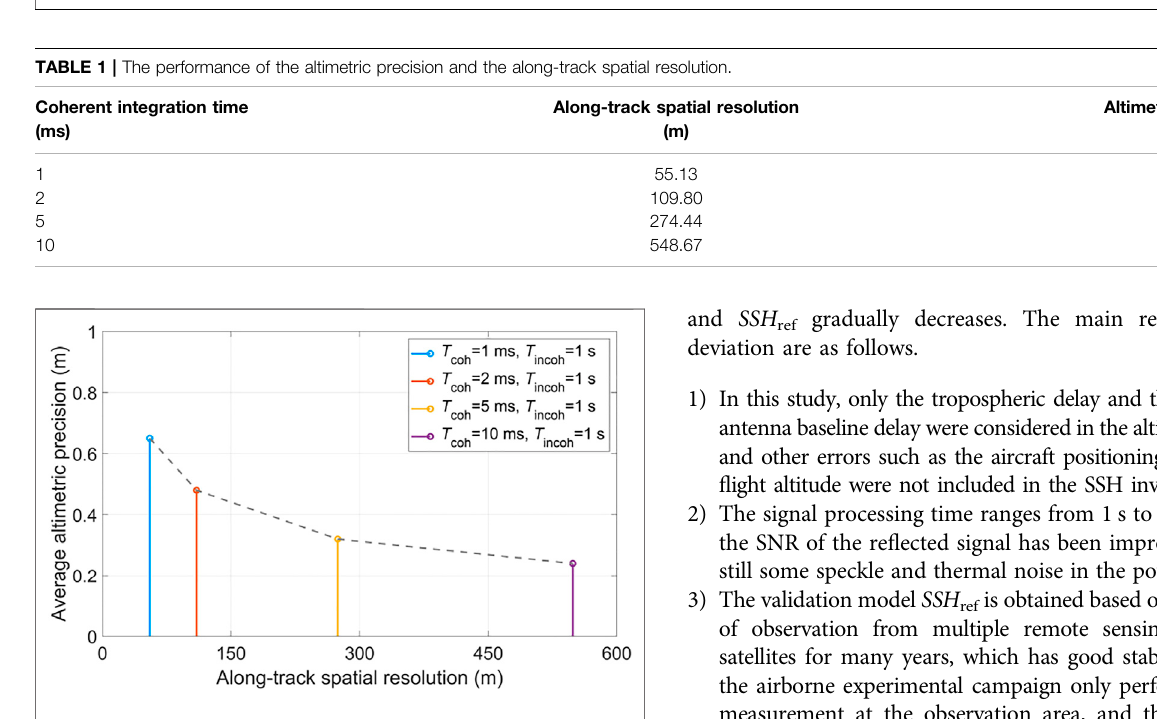
FIGURE 5 | Airborne iGNSS-R altimetric precision under different signal processing time.